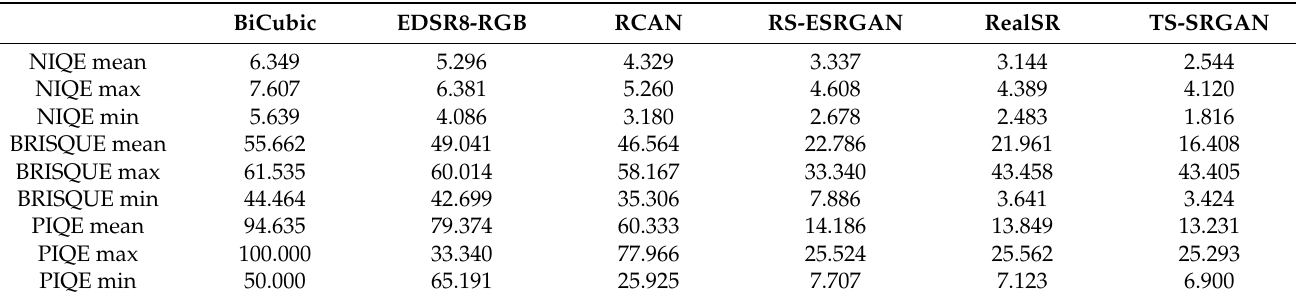
Figure 13. Distribution of evaluation values of NR-IQA metric PIQE. Table 3. Statistics of NIQE, BRISQUE and PIQE evaluation values.